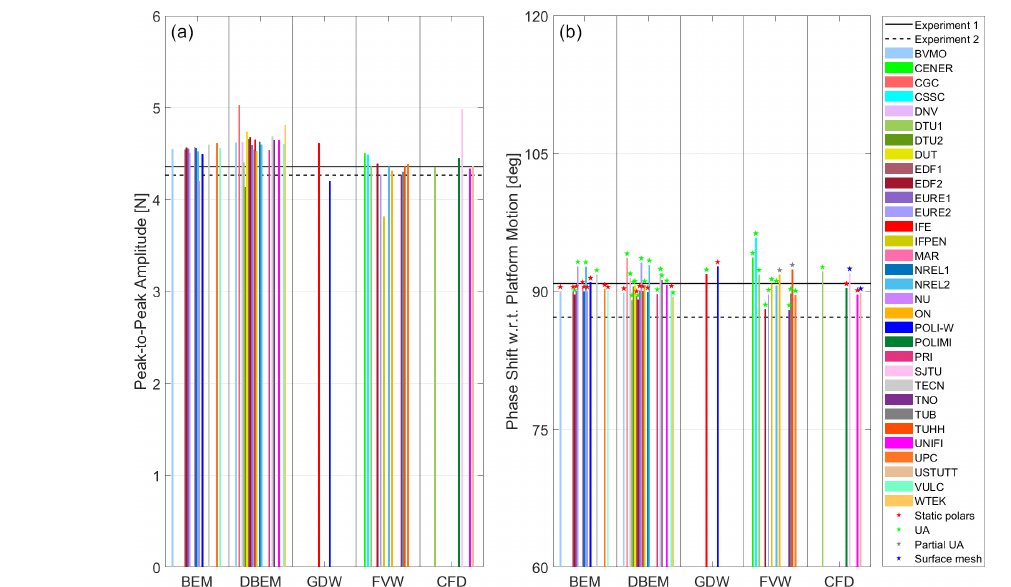
Figure 14. Aerodynamic rotor thrust peak-to-peak amplitude (a) and phase shift with regard to the platform motion (b) in Load Case 2.5.